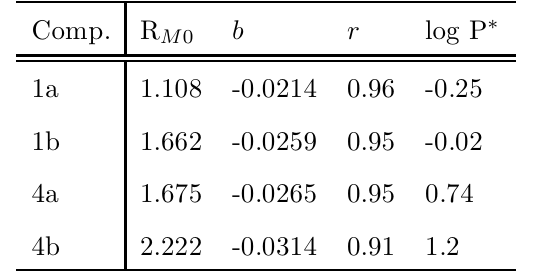
Table 7 R M 0 , b and r values obtained for 1a,b and 4a,